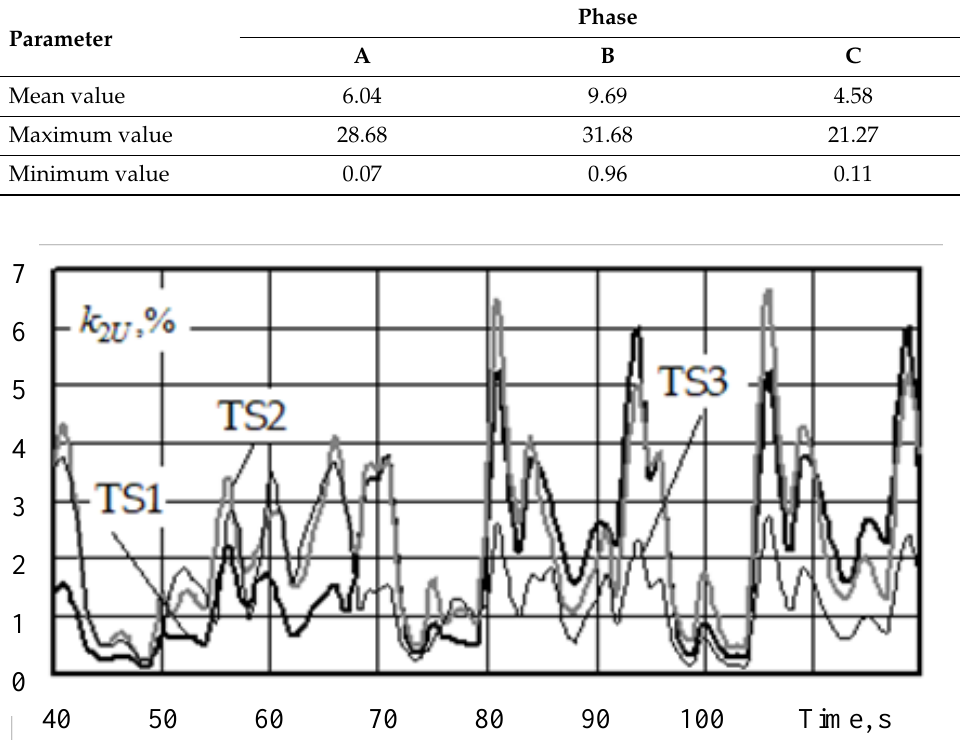
Table 7. Results of calculating total harmonic distortions at 6 kV buses of TS2.